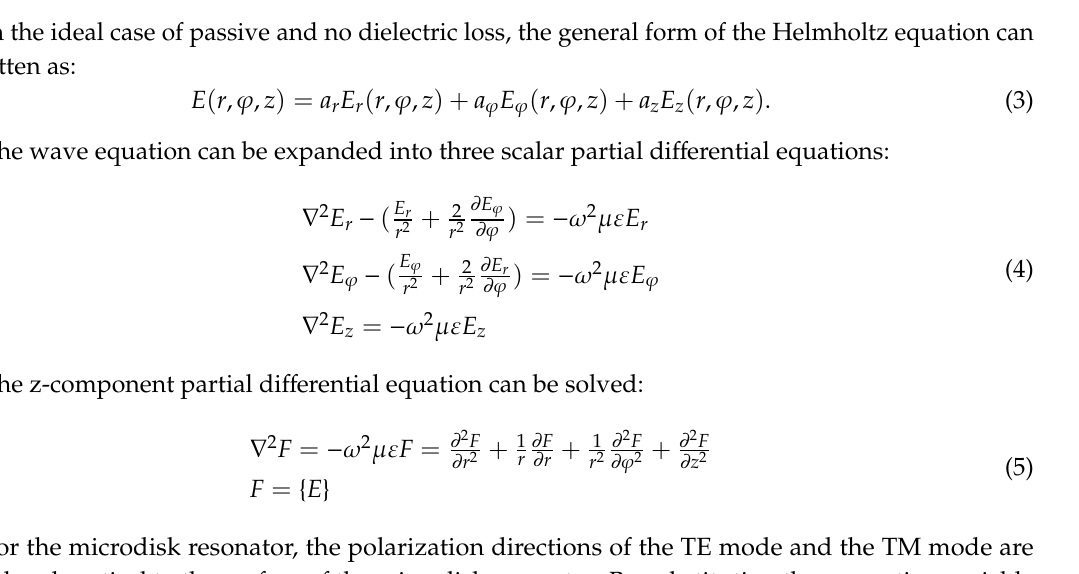
Figure 2. WGM resonator in a three-dimensional cylindrical coordinate